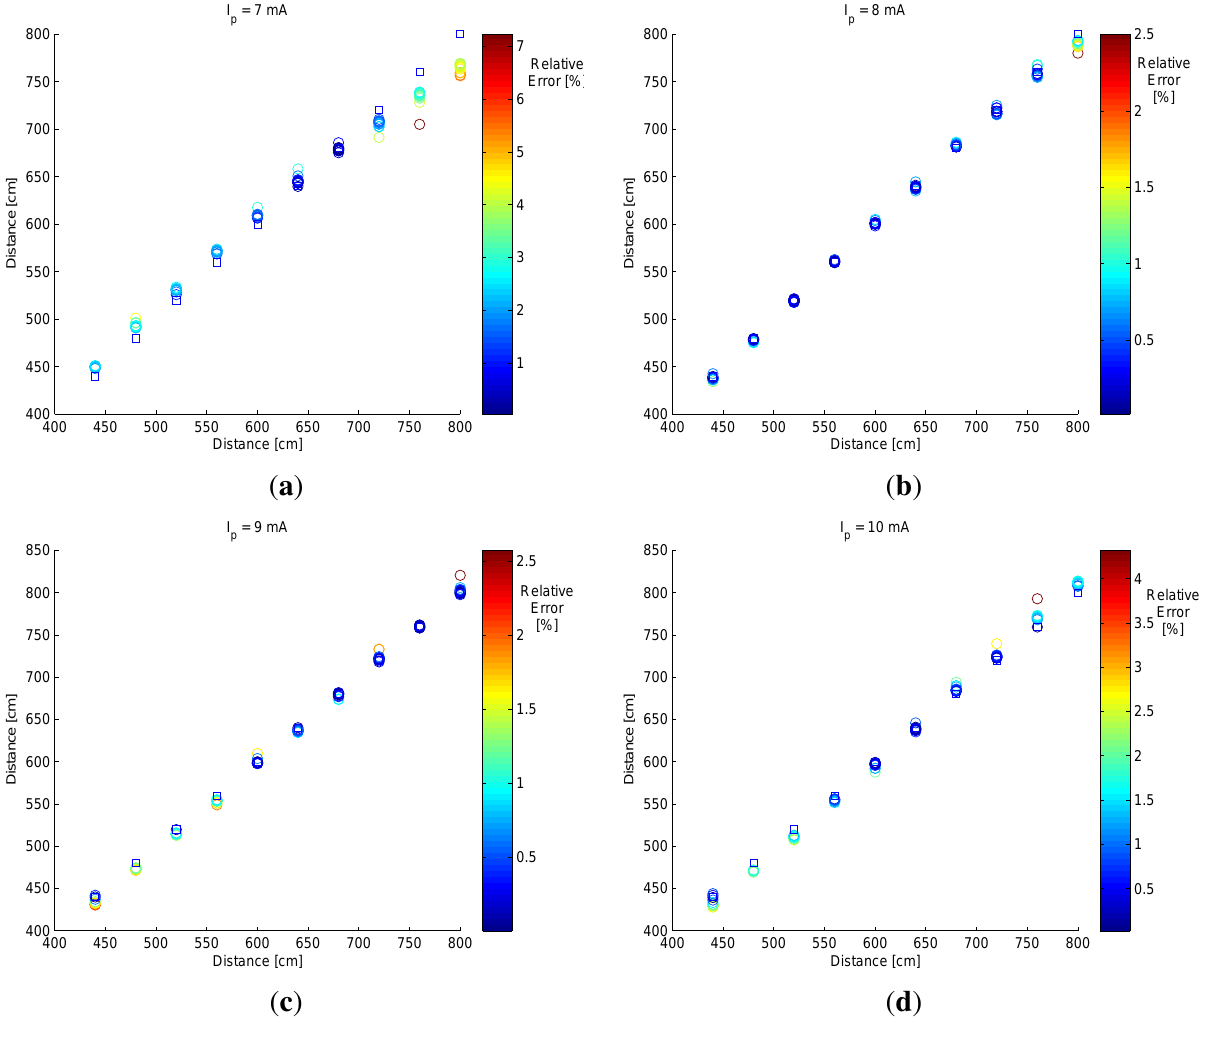
Figure 11. Results of distance estimation process considering all available differences of exposure time for different bias currents: (a) for I I = 9 mA and (d) for 10 mA. The line with square markers represents the real distance and p the colored circle represents the estimated distance. The color of the circles represents the relative error in distance estimation.